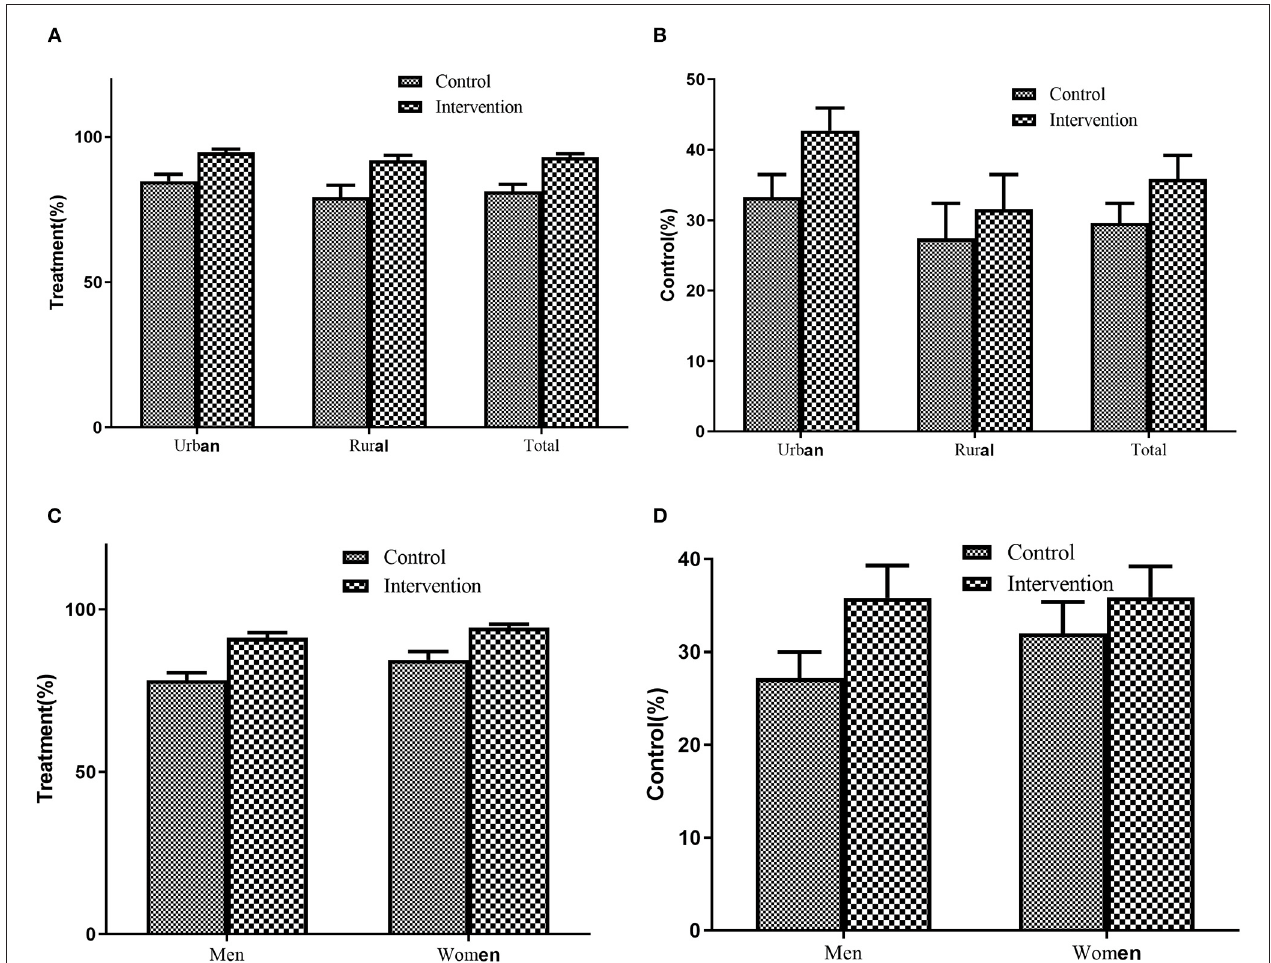
FIGURE 2 | Treatment and Control of Hypertension between intervention and control group. (A) Treatment by region, (B) Control by region, (C) Treatment by sex, (D) Treatment by sex. Adjusting for age, sex, BMI, ethnicity, education attainment, smoking status, consumption of alcohol, family history of hypertension, and region